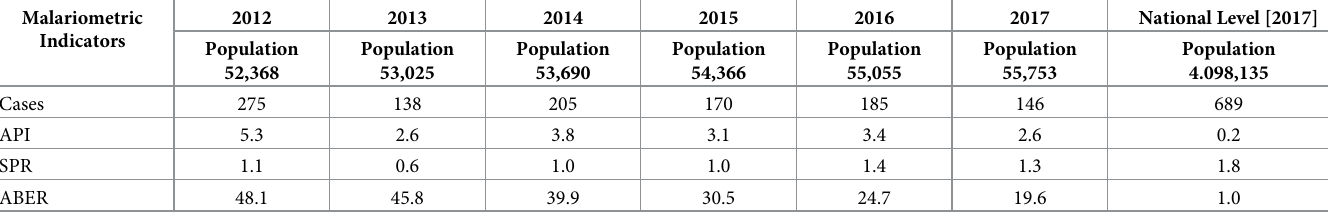
Table 3. Malaria surveillance indicators malariometrics in Darie´n Region, Panama, from 2012 to 2017. Malariometric